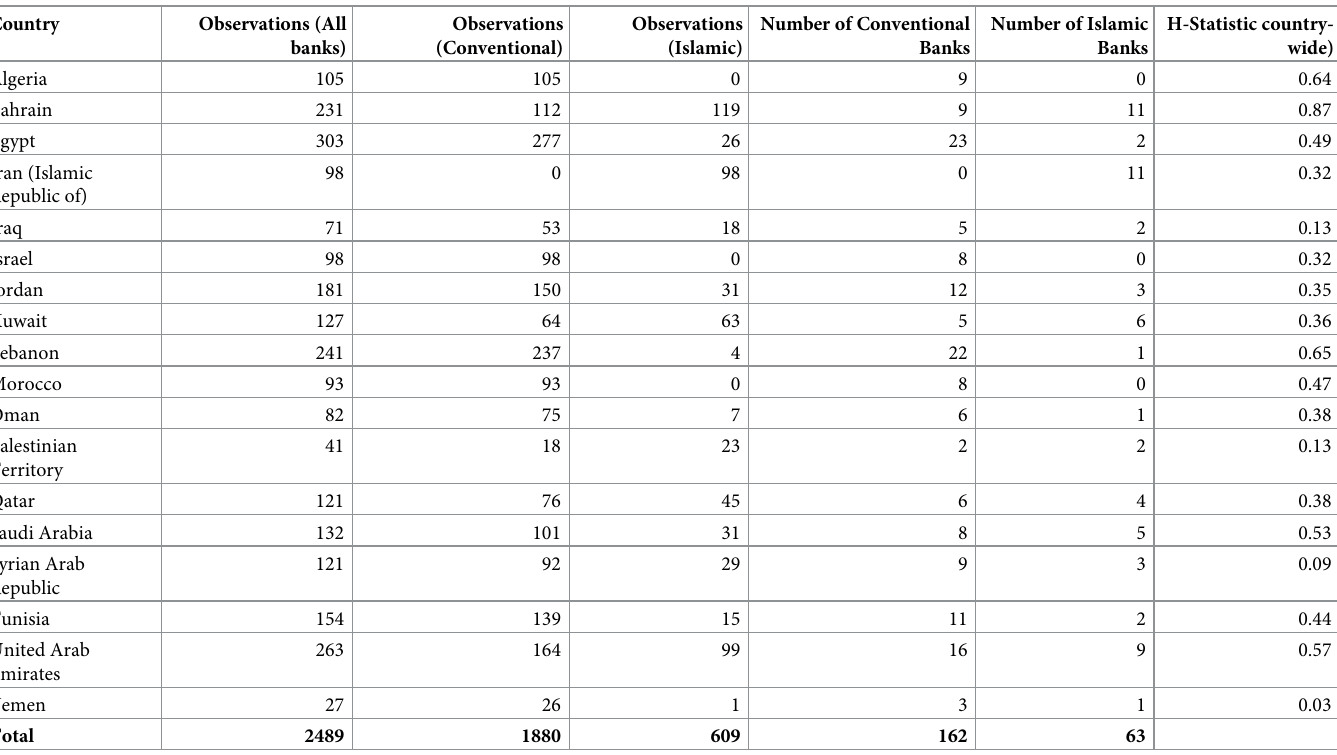
Table 1. Types of banks and H-Statistic per country. Country Observations (All